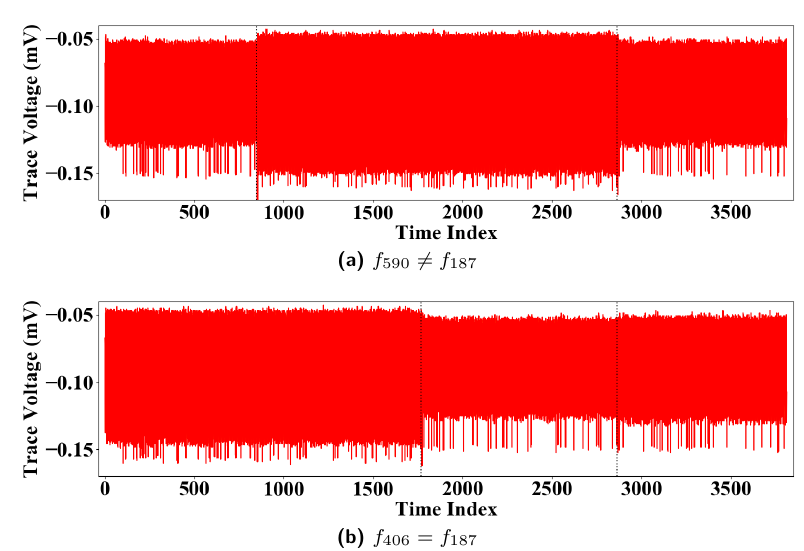
Figure 12: The CISPA on Countermeasure 1: the second